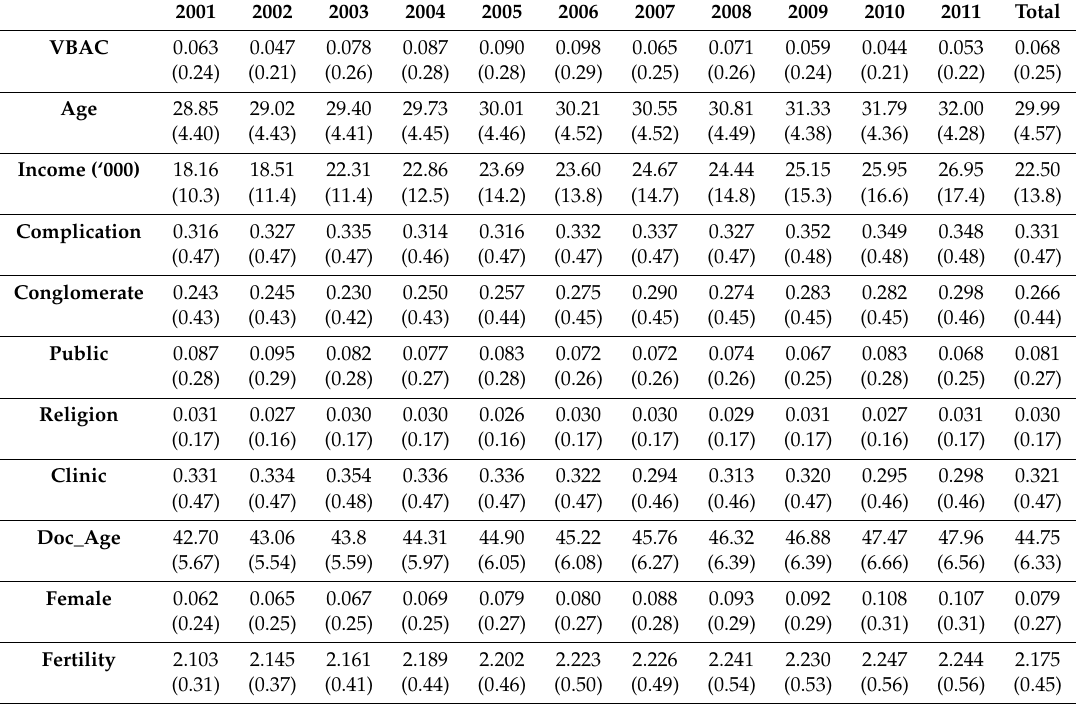
Table 2. Statistical